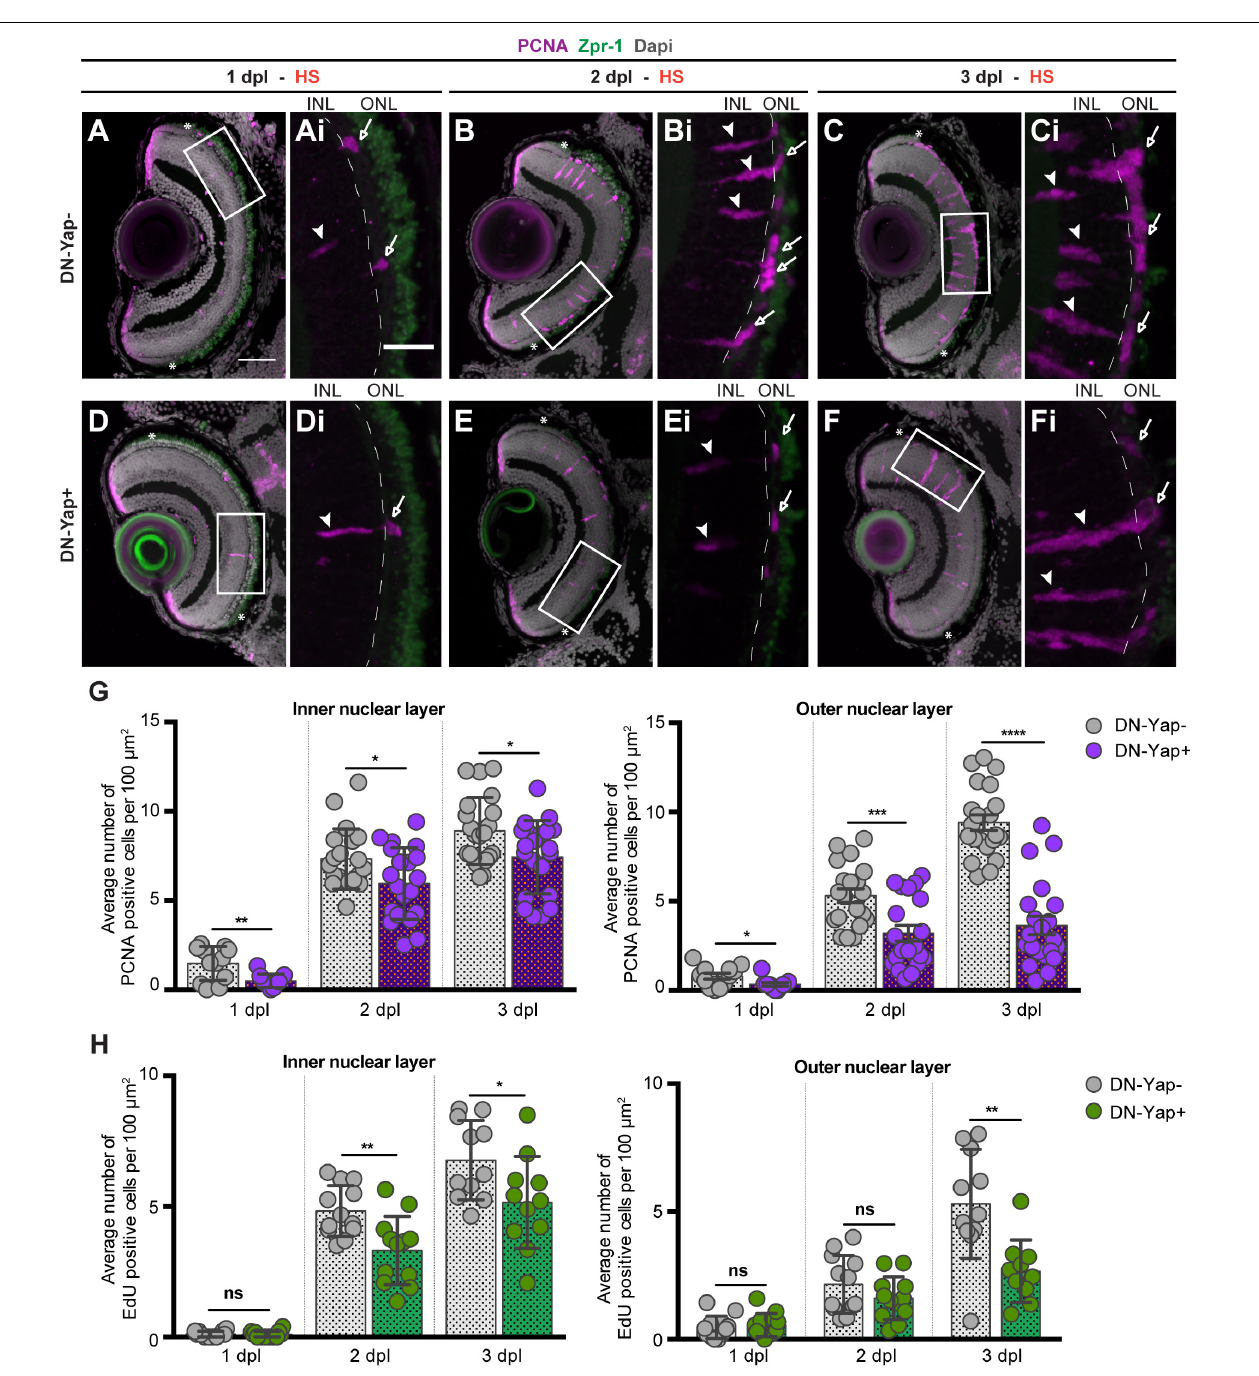
FIGURE 2 | Yap inhibition reduces cell proliferation in the retina after photoreceptor-induced light lesion. (A–F) Transverse cryosections of DN-Yap − (A–C) and DN-Yap+ (D–F) retinas immunostained for proliferating cell nuclear antigen (PCNA) (magenta) and Zpr-1 (green) and counterstained with DAPI (gray). White arrowheads and arrows indicate PCNA+ cells in the inner nuclear layer (INL) and outer nuclear layer (ONL), respectively, at 1 dpl ( A,D magnified, Ai , Di ), 2 dpl ( B,E , magnified, Bi,Ei ), and 3 dpl ( C,F , magnified, Ci,Fi ). (G) Quantification of PCNA + cells in DN-Yap − and DN-Yap + larva retinas from 1 to 3 dpl, in the INL and ONL. (H) Quantification of EdU + cells in DN-Yap − and DN-Yap + larva retinas from 1 to 3 dpl, in the INL and ONL. ns, non-significant; * p < 0.05, ** p < 0.01, *** p < 0.001, **** p < 0.0001. Unpaired t -test with Welch’s correction. Asterisks delimitate the lesioned region. Dashed lines delimitate INL from ONL. White boxes delimitate magnified (Ai–Fi) . Scale bars correspond to 50 µ m in (A,C) , and 20 µ m in magnified (Ai,Ci) .